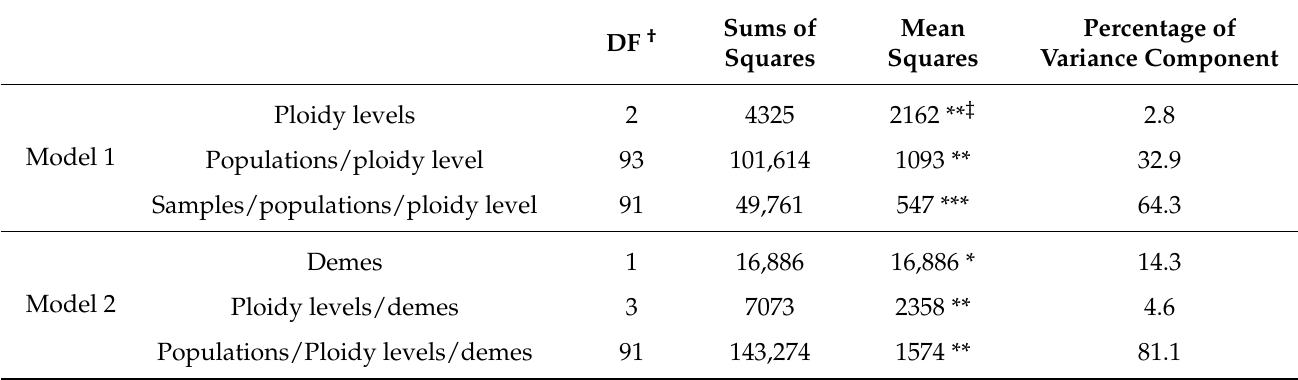
Table 1. Analysis of molecular variance (AMOVA) for 96 prairie cordgrass populations based on hierarchical models. The first model consisted of ploidy levels, population within ploidy level, samples within population was calculated using 9315 SNPs data. The second model consisted of demes, ploidy levels within deme, and populations within ploidy